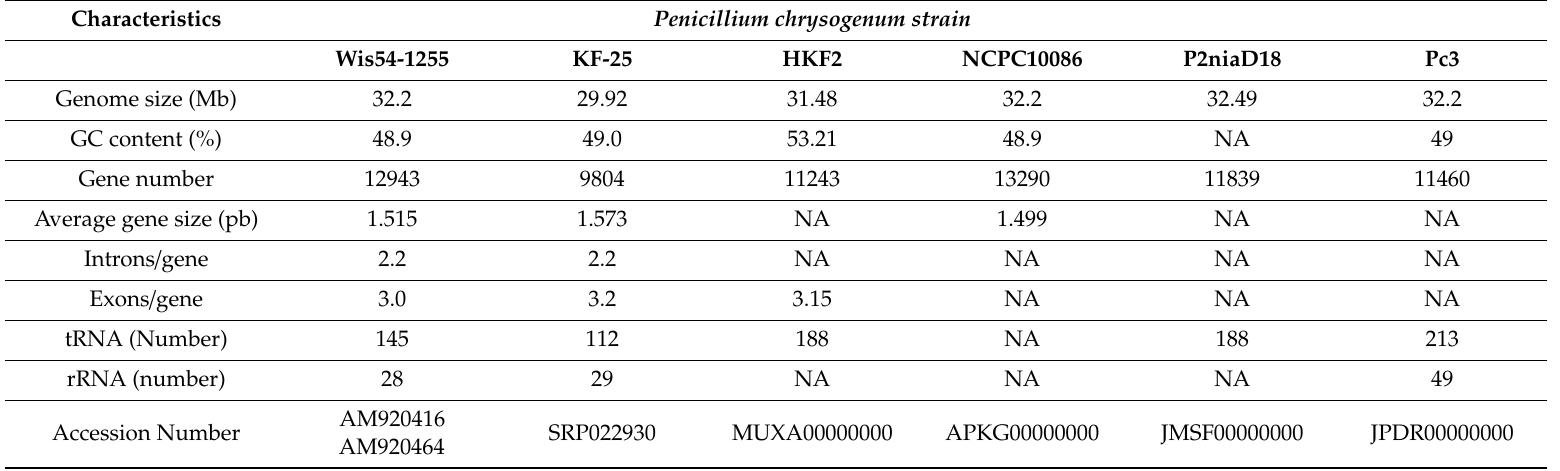
Table 2. Molecular characteristics of the genomes of sequenced P. chrysogenum strains.